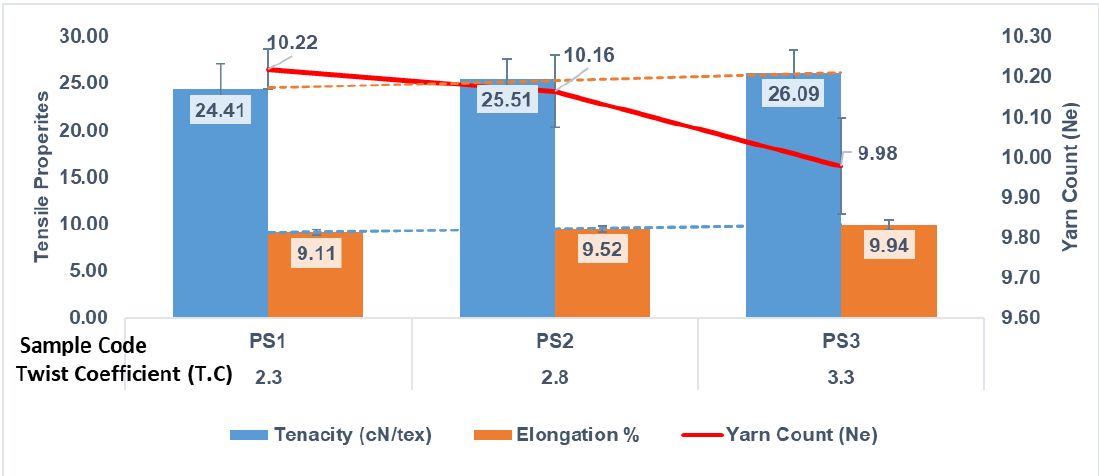
Figure 2. Effect of TC on tensile properties of conventional ring-spun MFHSYs. Table 5. Linear regression analysis of tensile properties for ring-spun and plied MFHSYs .